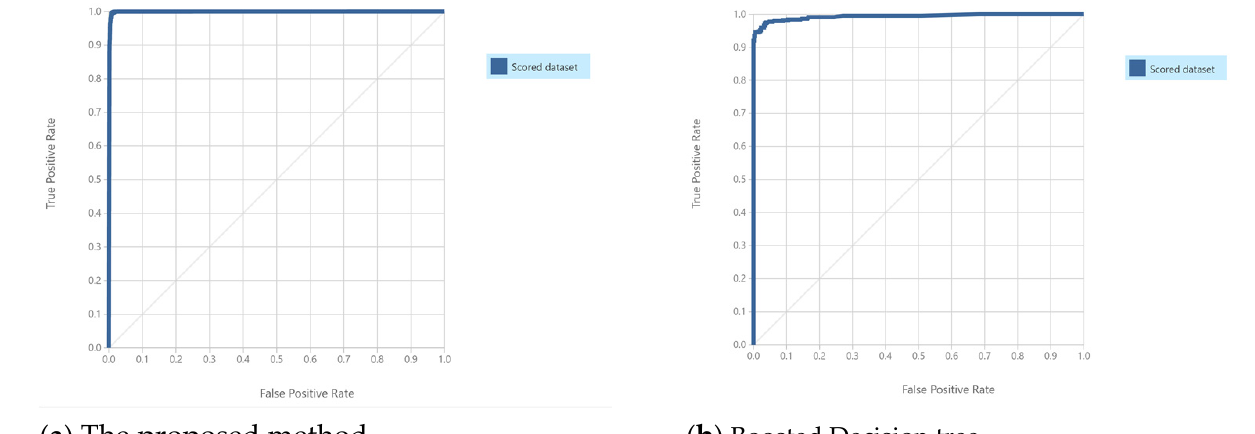
Table 6. Results of blister packing machine case. Type